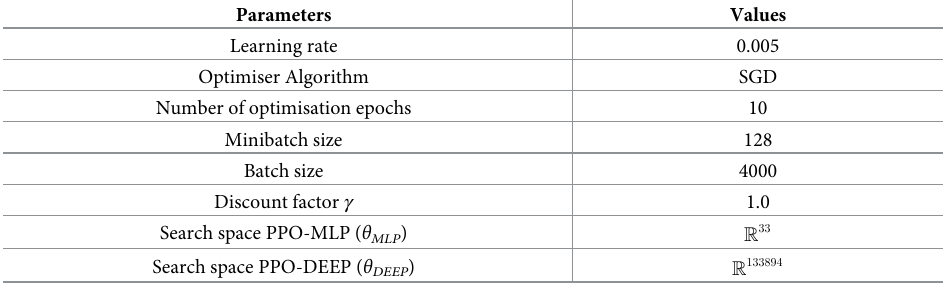
Table 1. Parameters used for the PPO algorithm. See Supplementary Materials for an extensive analysis of parameter